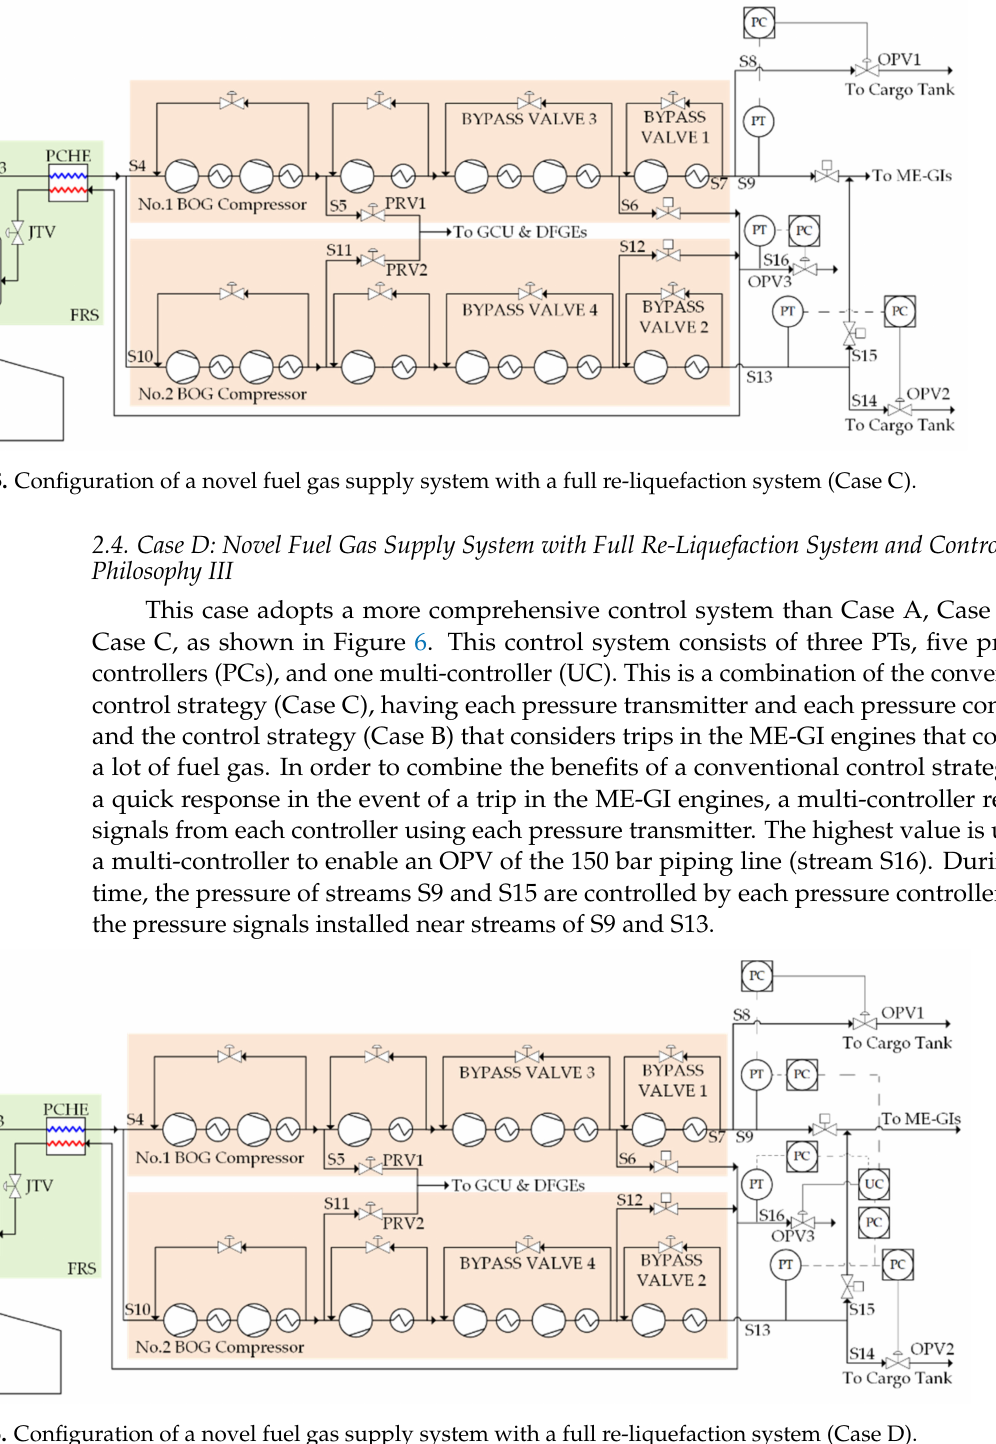
Figure 6. Configuration of a novel fuel gas supply system with a full re-liquefaction system (Case